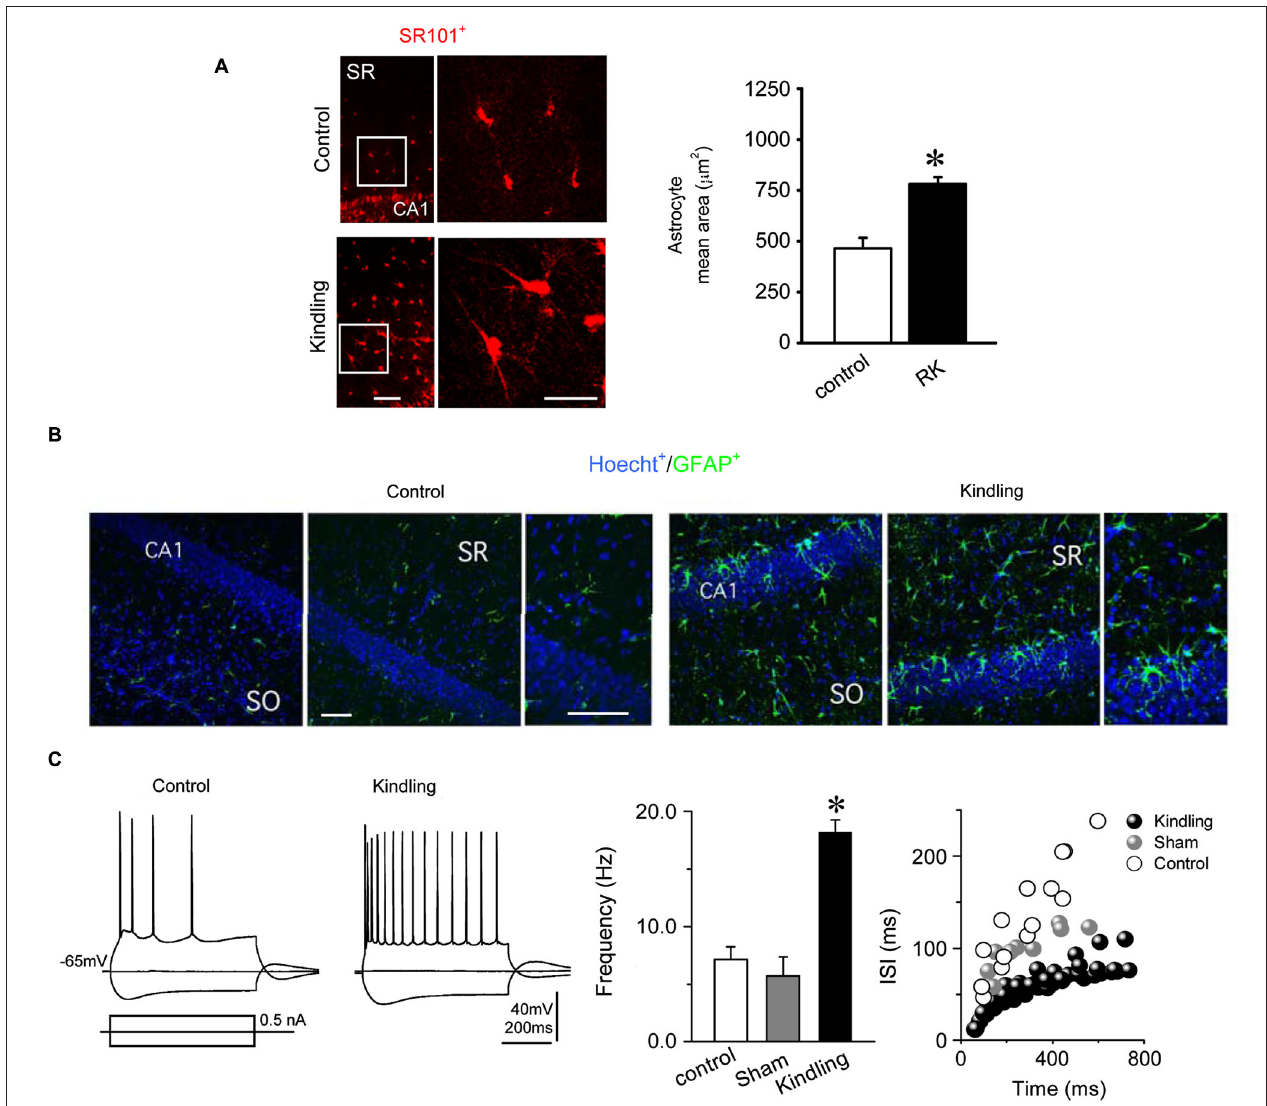
similar levels of Hoechst in both experimental conditions were found (78% in SR and 88% in SO; n = 8 slices in RK and control). (C) (Left) Representative voltage membrane responses from control and kindled CA1 pyramidal neurons, evoked by the injection of hyperpolarizing and depolarizing current pulses ( ± 0.5 nA; 750 ms), recorded at − 65 mV imposed membrane potential. (Right) Mean frequencies and inter-spike interval (ISI) of AP discharges evoked by pulses of + 0.5 nA (Mann Whitney test, * p < 0.05; n = 5 in RK and n = 3 in control; calibration bars: 100 µ m, for all